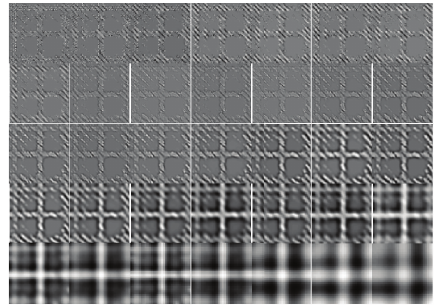
Figure 9: The normal DOG scale space under condition 1.